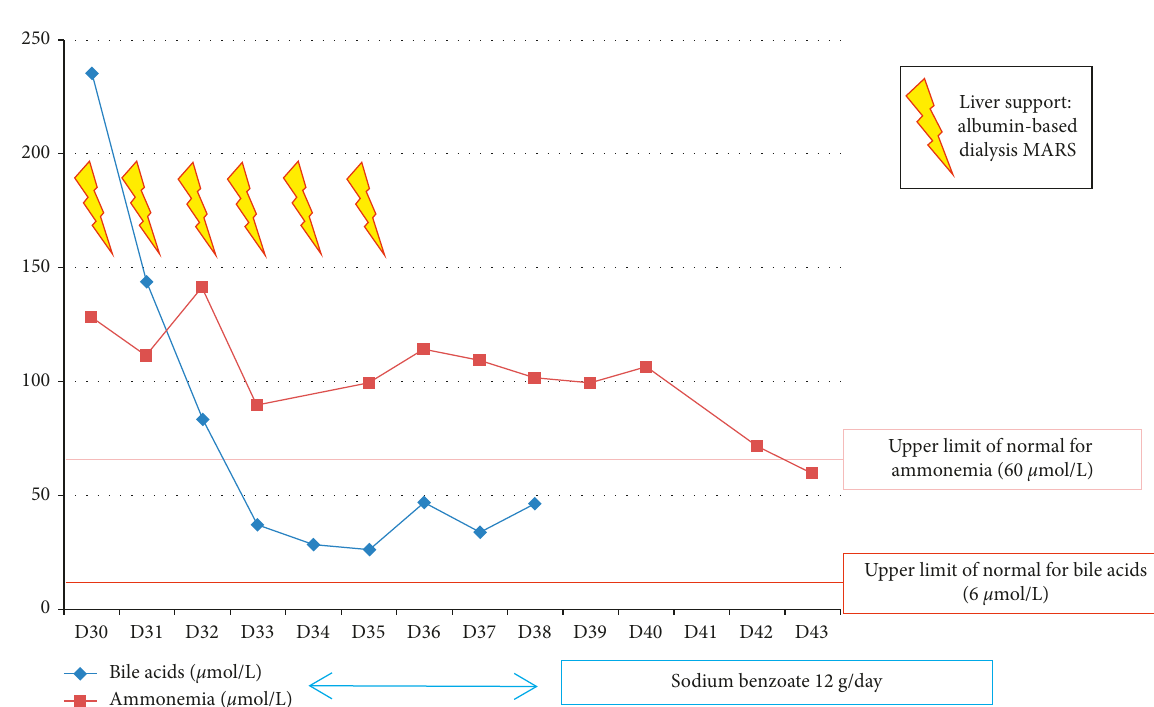
Figure 4: Variation of bile acids and ammonemia from D30 to D43 of the induction